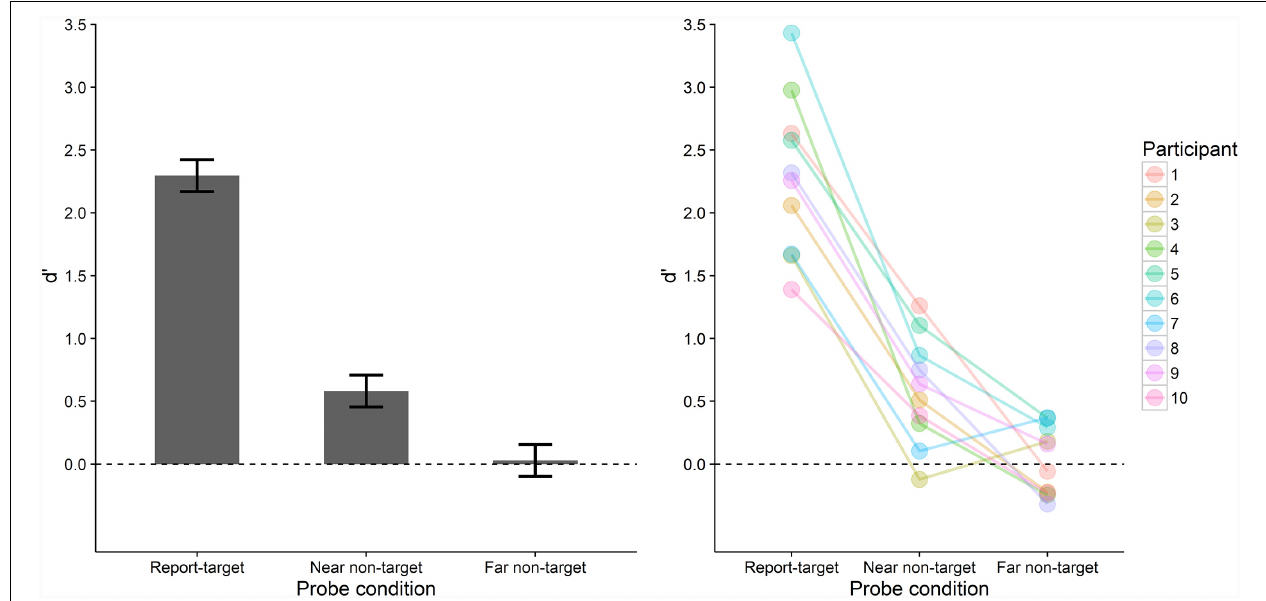
FIGURE 5 | Mean probe recognition performance ( d ’) in Experiment 2 across all participants (bars, left) and for individual participants (colored points, right) in the three conditions. Error-bars indicate ± 1 SE for within-subjects designs (Loftus and Masson, 1994). Chance level is indicated by the dashed